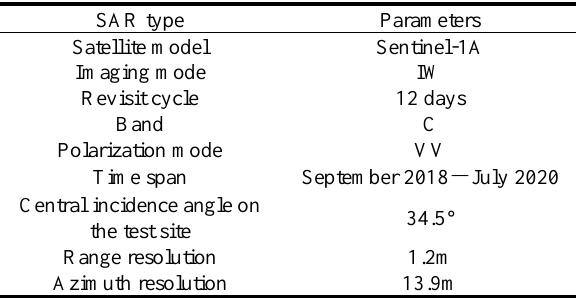
Table 1. Specific parameters of Sentinel-1A